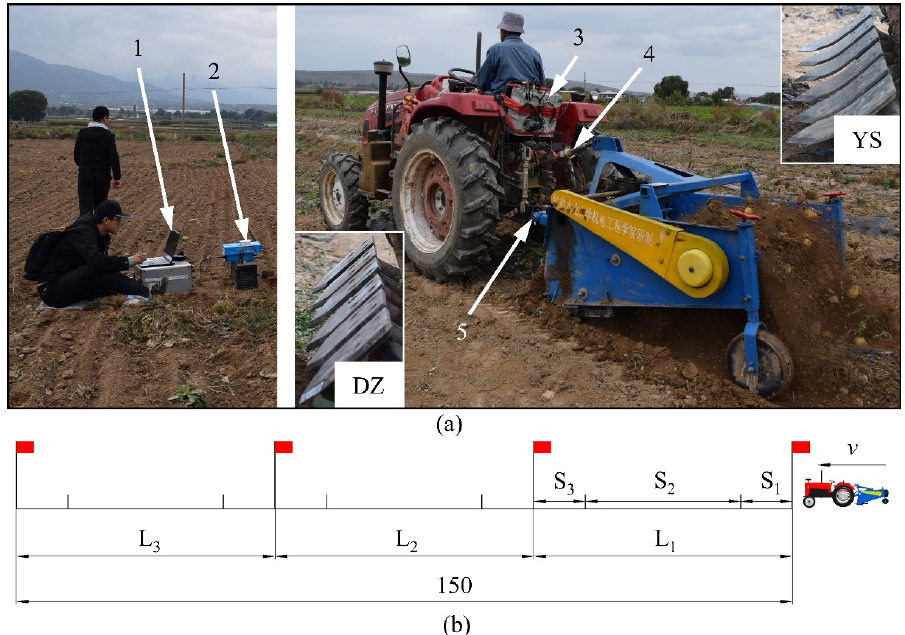
Figure 8. Testing system used in field draught force tests ( a ): (1) laptop, (2) signal receiver, (3) signal acquisition and transmission device, (4) upper pull rod sensor and (5) lower suspension pin sensor. Sampling area partition for field draught force experiments ( b ): L 1 , L 2 and L 3 represent the experi- mental travelling distance, S 1 represents the preparation area, S 2 represents the sampling area and S 3 represents the finishing